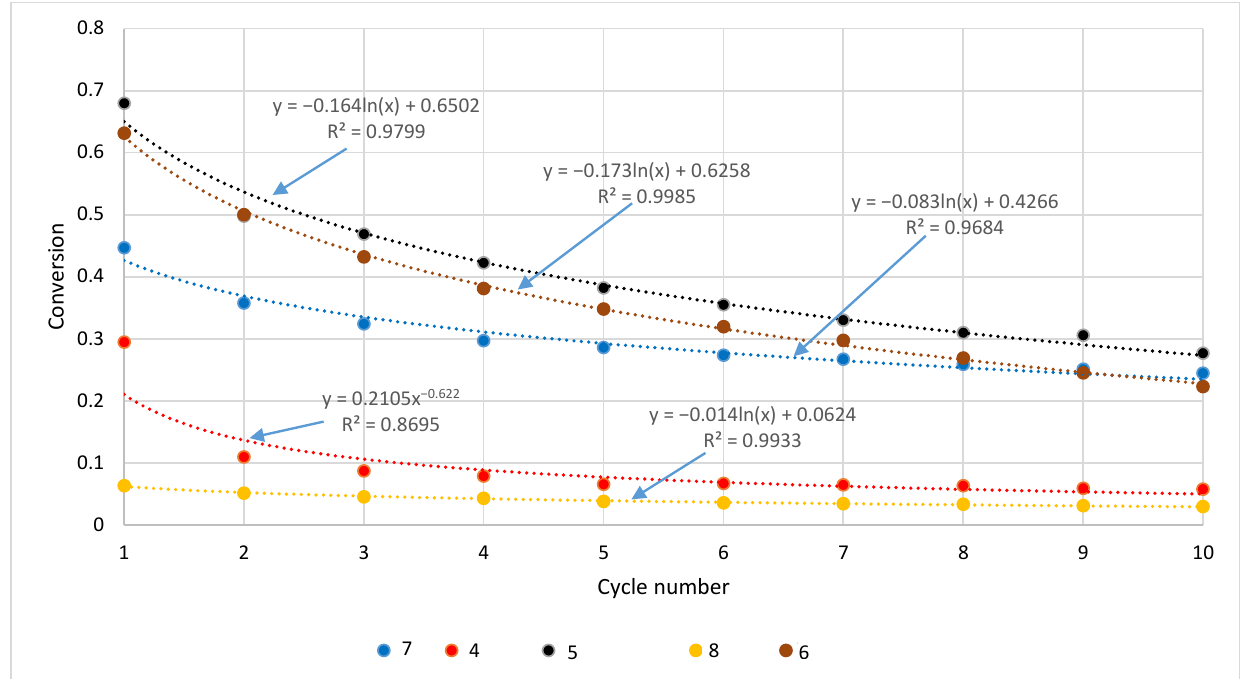
Figure 16. The conversion of carbonate rocks in the CaL process.